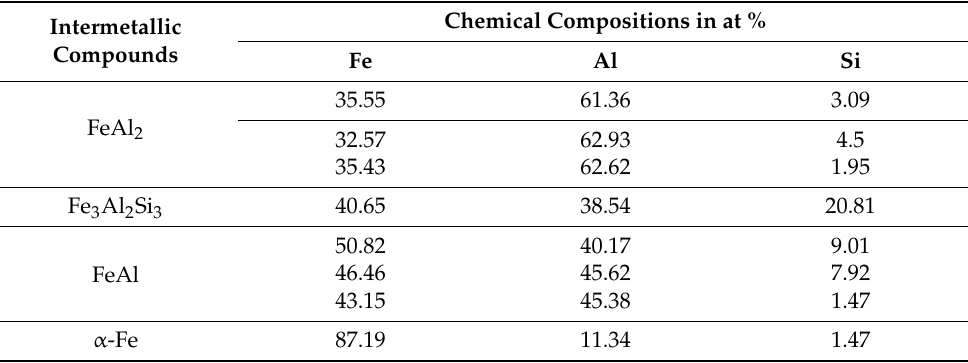
Table 4. EDS analysis of intermetallic compounds in the Al–Si coating layers though different heat treatment methods.